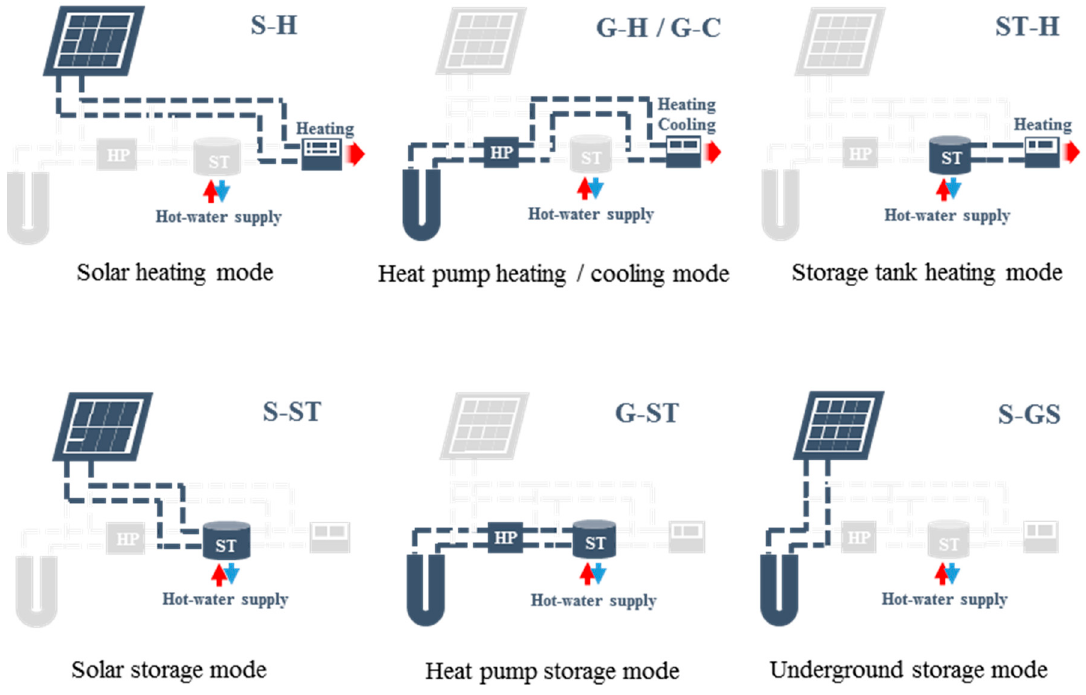
Figure 2. Operation modes of Geo-PVT system.